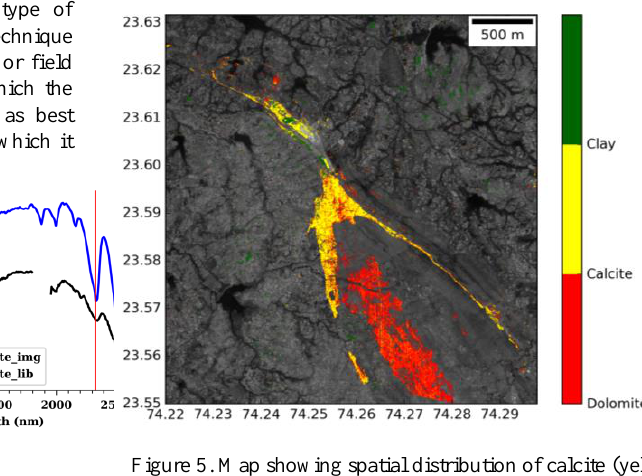
Figure 5. Map showing spatial distribution of calcite (yellow color), dolomite (red) and clay (blue) minerals. Presence of calcite indicates relatively pure marble while dolomite indicates occurrence of dolomitic